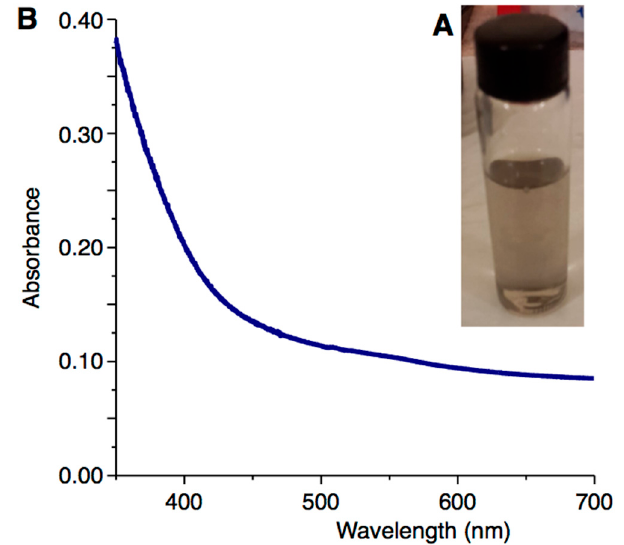
Figure 3. dc-APGD-mediated synthesis of PVP-PtNPs. ( A ) Color exhibited by the mixed working Figure 3. dc ‐ APGD ‐ mediated synthesis of PVP ‐ PtNPs. ( A ) Color exhibited by the mixed working solution after dc-APGD treatment and related to production of PVP-PtNPs; ( B ) the UV/Vis spectrum solution after dc ‐ APGD treatment and related to production of PVP ‐ PtNPs; ( B ) the UV/Vis spectrum of of PVP ‐ PtNPs.